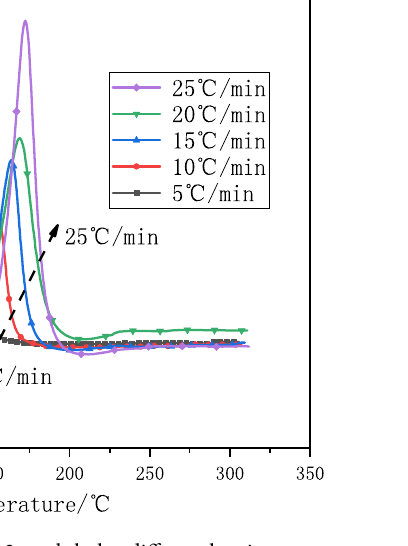
Figure 3. DSC curves of 1-nitroso-2-naphthol at different heating